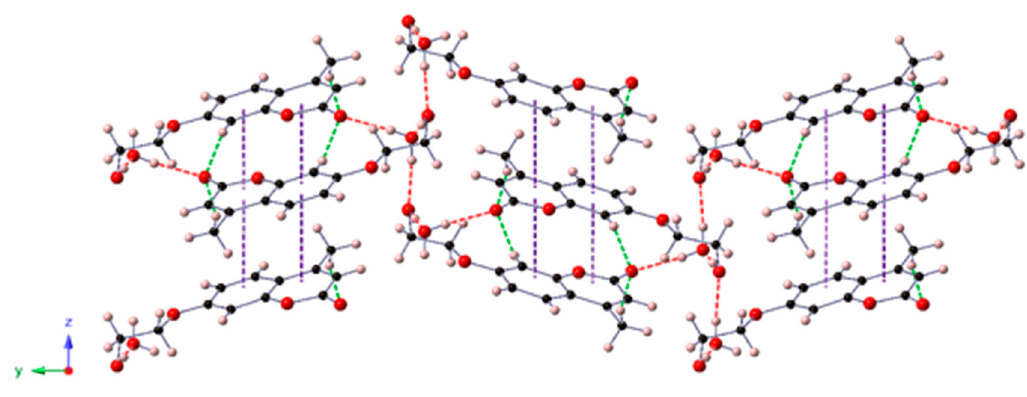
Figure 8. View of the crystal packing of HEOMC along the crystallographic x-axis. Intermolecular interactions are depicted as dashed lines: O-H ··· O, red; C-H ··· O, green; π - π purple.